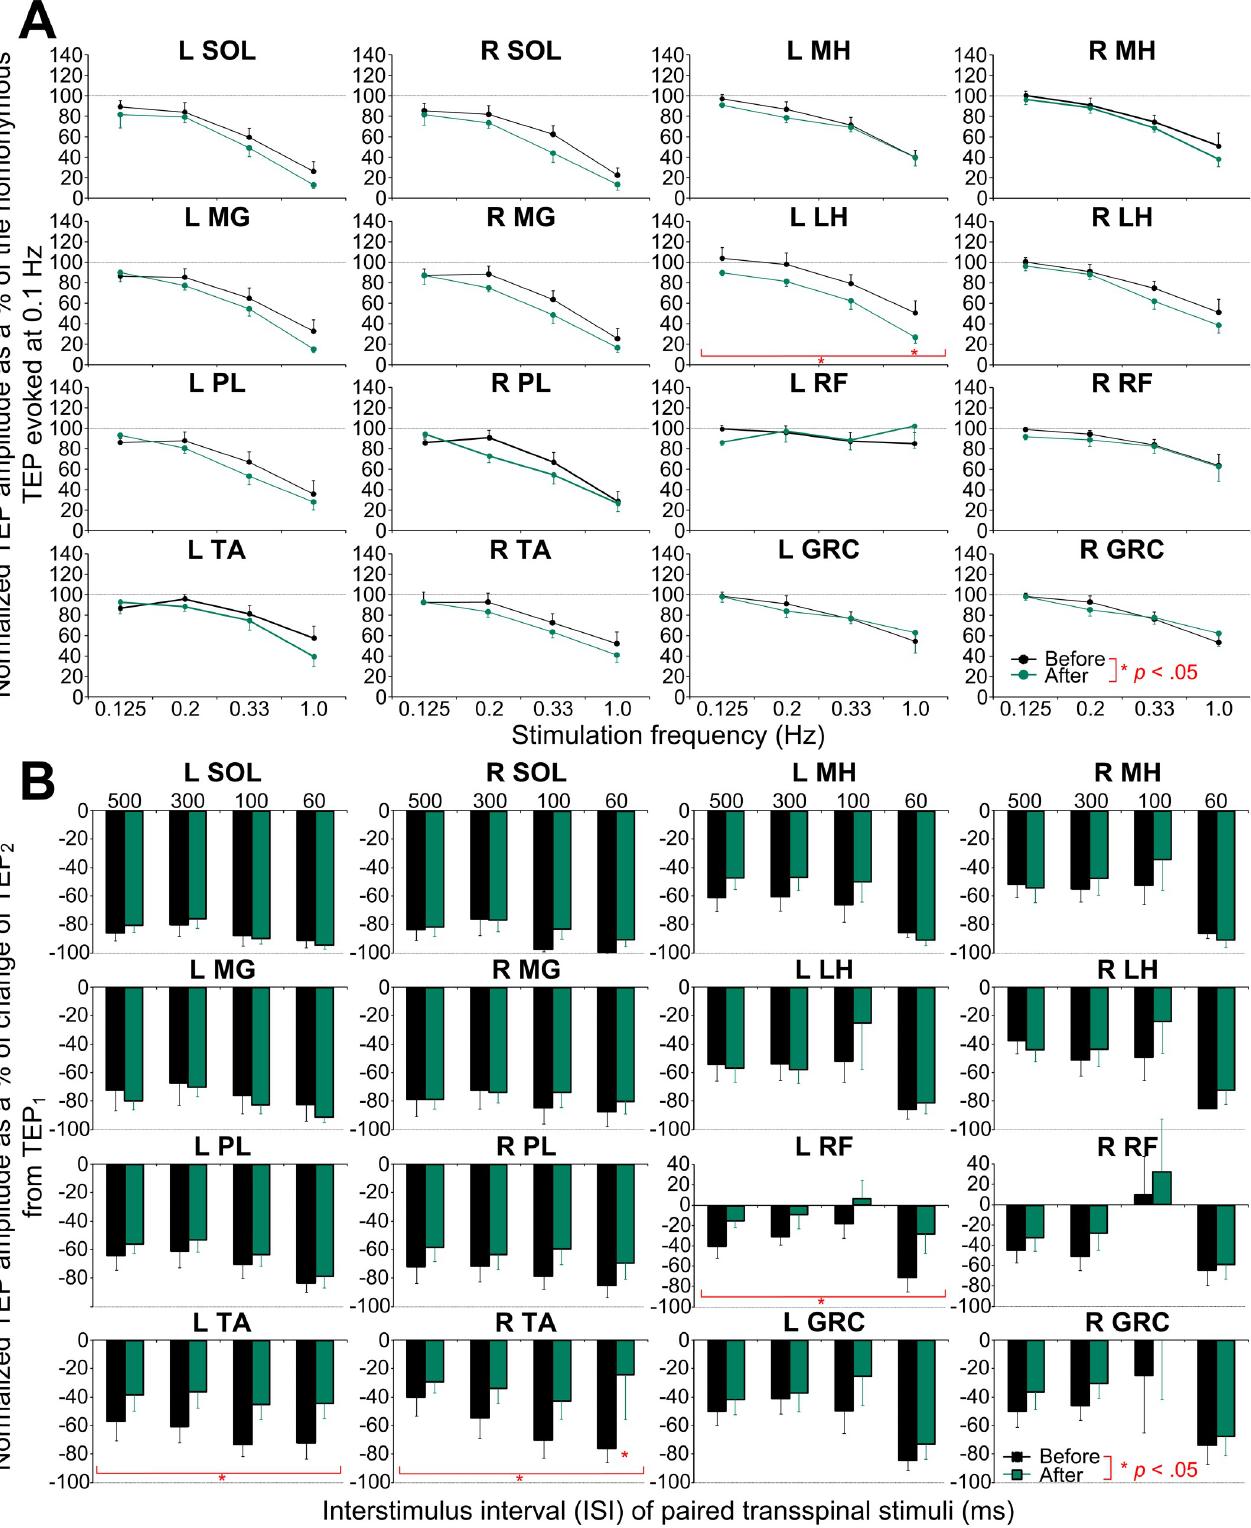
Fig 7. Homosynaptic and postactivation transspinal evoked potential (TEP) depression before and after transspinal stimulation in healthy control subjects. (A) Overall percent change of TEPs recorded at 0.125, 0.2, 0.33 and 1.0 Hz from the associated TEP recorded at 0.1 Hz before (black lines) and after